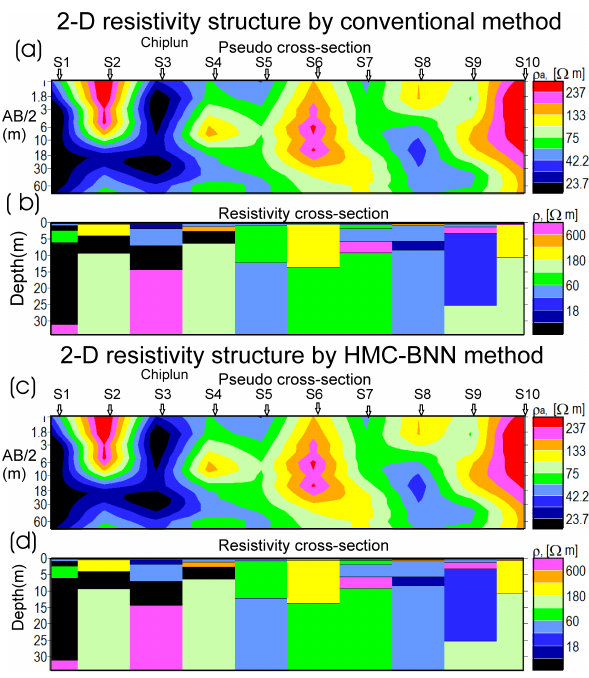
Fig. 9. Resistivity structure of sounding points s1–s10 by (a, b) sin- gular value decomposition (SVD)-based conventional method (c, d) Hybrid Monte Carlo (HMC)-based Bayesian neural network (BNN) approaches.